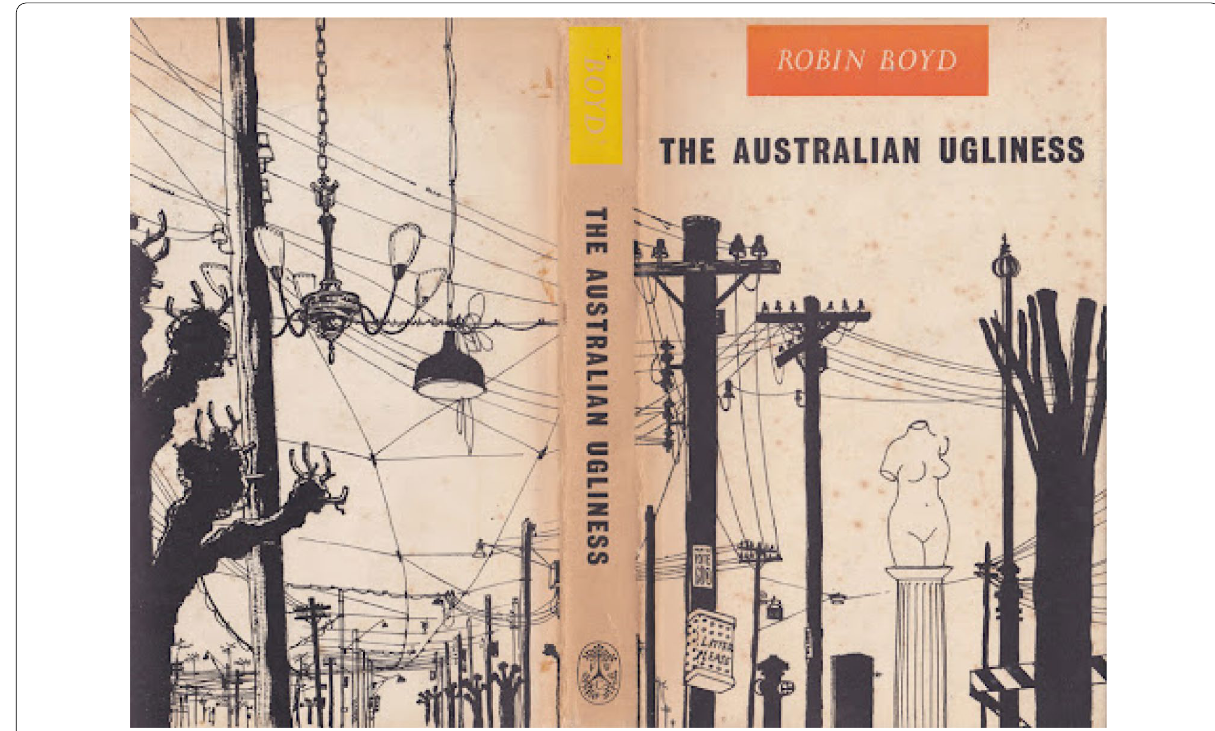
Fig. 1 Front cover and back cover of Boyd (1960) © Estate of Robin Boyd, courtesy Robin Boyd Foundation. https:// robin boyd. org.